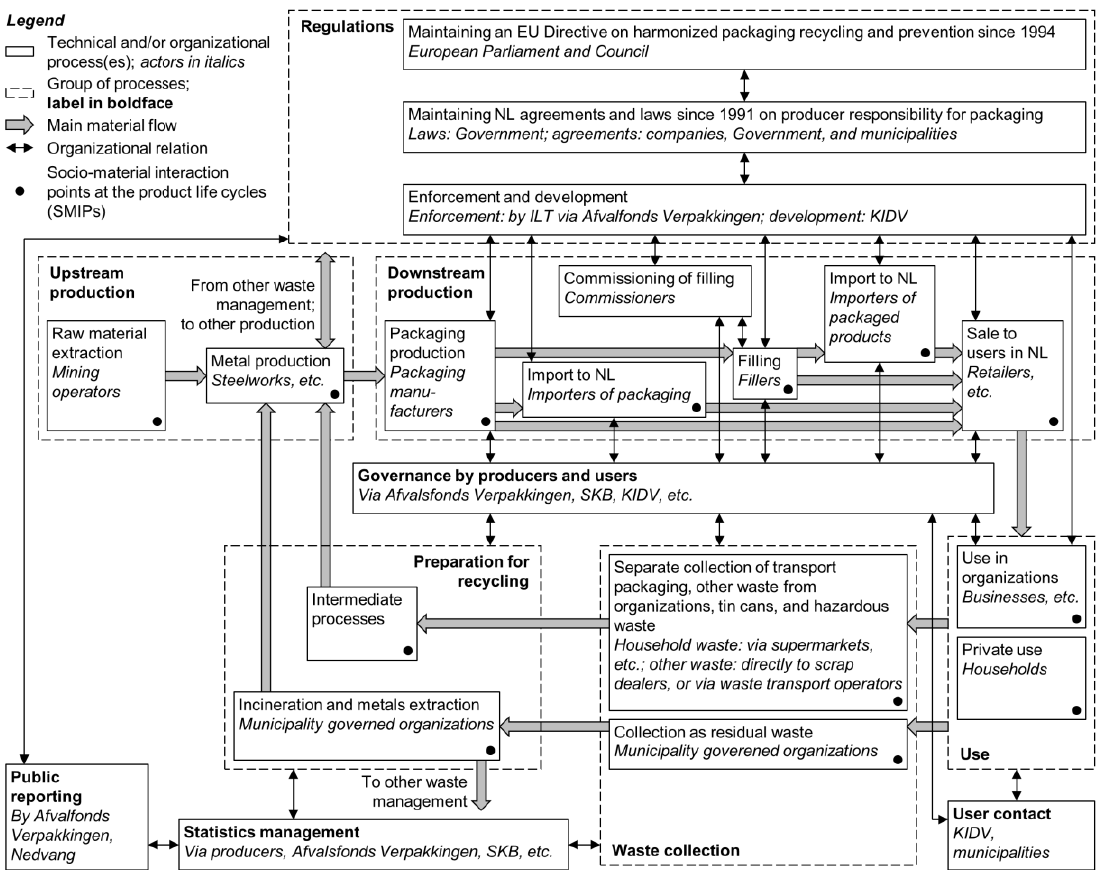
Figure 4. Central flows and organization in the Dutch metal packaging PCO, mainly for 2013–2017. ILT = Inspectie Leefomgeving en Transport, KIDV = Netherlands Institute for Sustainable Packaging, NL = the Netherlands, SKB = Stichting Kringloop Blik.